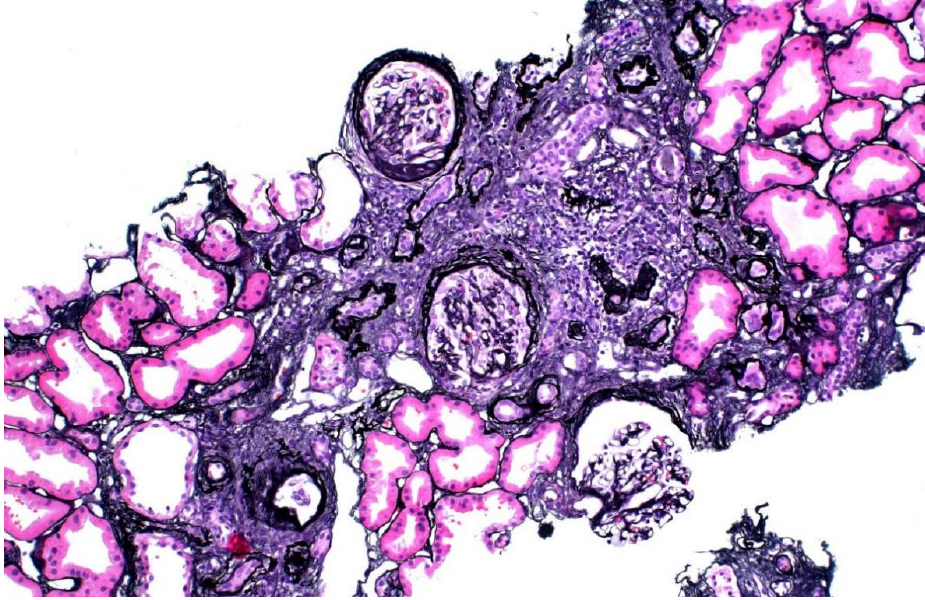
Figure 2. Kidney biopsy of donor 1, showing focal global glomerulosclerosis, arteriosclerosis, tubular atrophy and interstitial fibrosis.